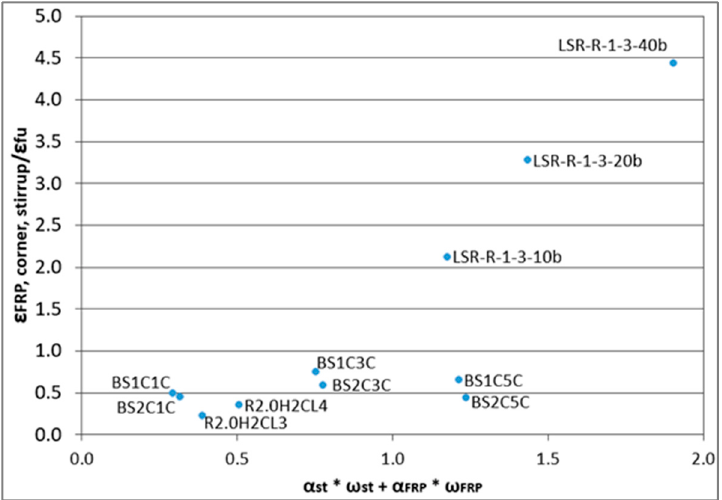
Figure 1. Correlation between the ratio of the FRP strain at the corner of the stirrups and the ultimate FRP strain according to the manufacturers ( ε FRP,corner,stirrup / ε fu ) and the sum α st × ω st + α FRP × ω FRP .